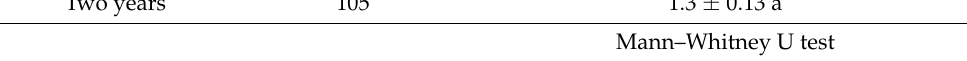
Table 1. The fresh matter (FM) of tuber clusters, the number of tubers in one cluster, and number of progeny clusters (PC) for different age clusters in the years 2017–2019.